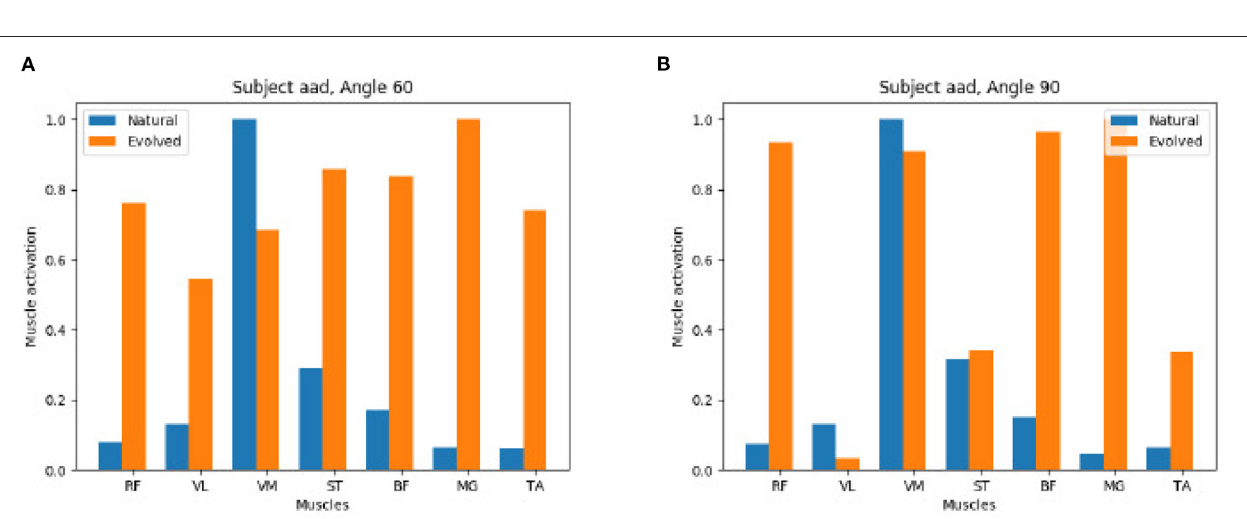
FIGURE 10 | Negative comparison of natural vs. evolved synergies: The Genetic Algorithm recreates the knee torque of study participants but identifies different synergies to reach the same torque. (A) Subject aad Angel 60. (B) Subject aad Angel